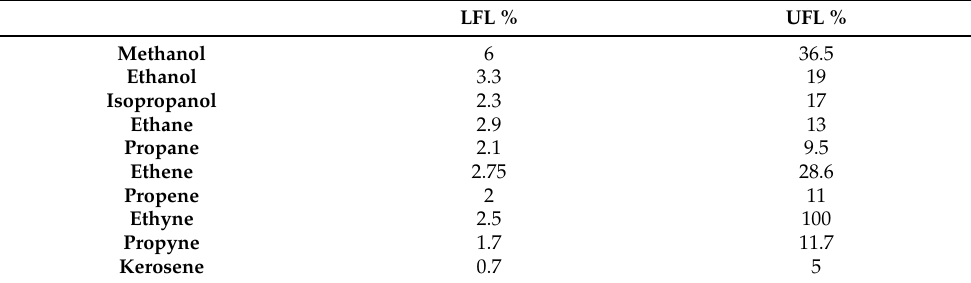
Table 14. Flammable limits in air. Data from Ref.